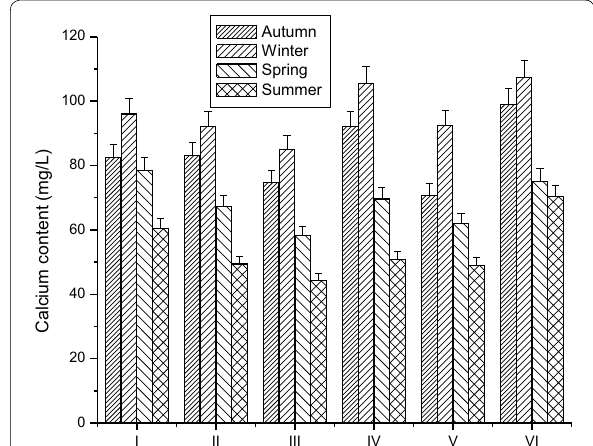
Fig. 11 Spatial and temporal variations of calcium content (mg/L) in Hokersar wetland during September 2012–August 2013